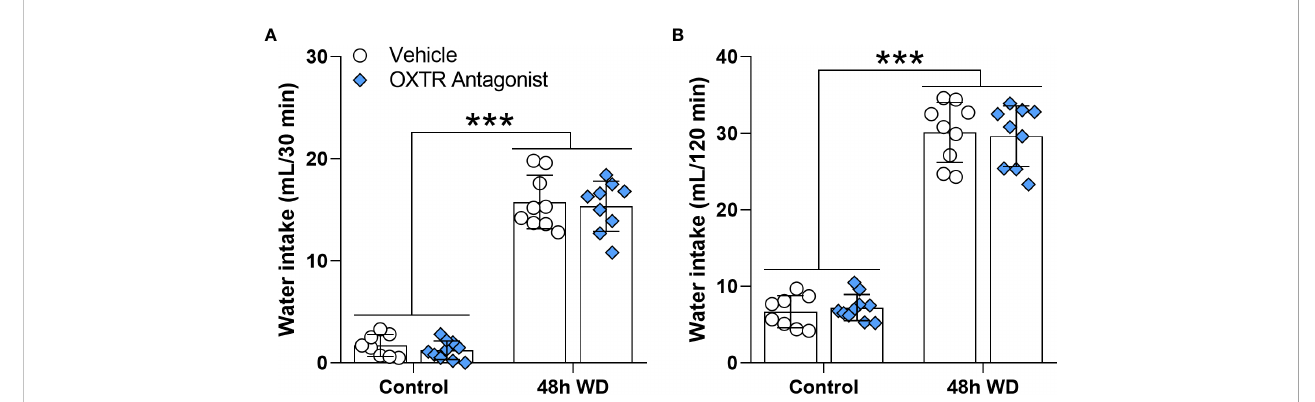
FIGURE 7 Effects of oxytocin receptor antagonist microinjection in the central amygdala of 48 h water-deprived male adult rats on water intake during (A) 30 and (B) 120 minutes. Values are mean ± SD. The number of animals used per group was: Control + vehicle = 8; Control + antagonist = 10; 48 h WD + vehicle = 9; 48 h WD + antagonist = 9. Data were submitted to two-way